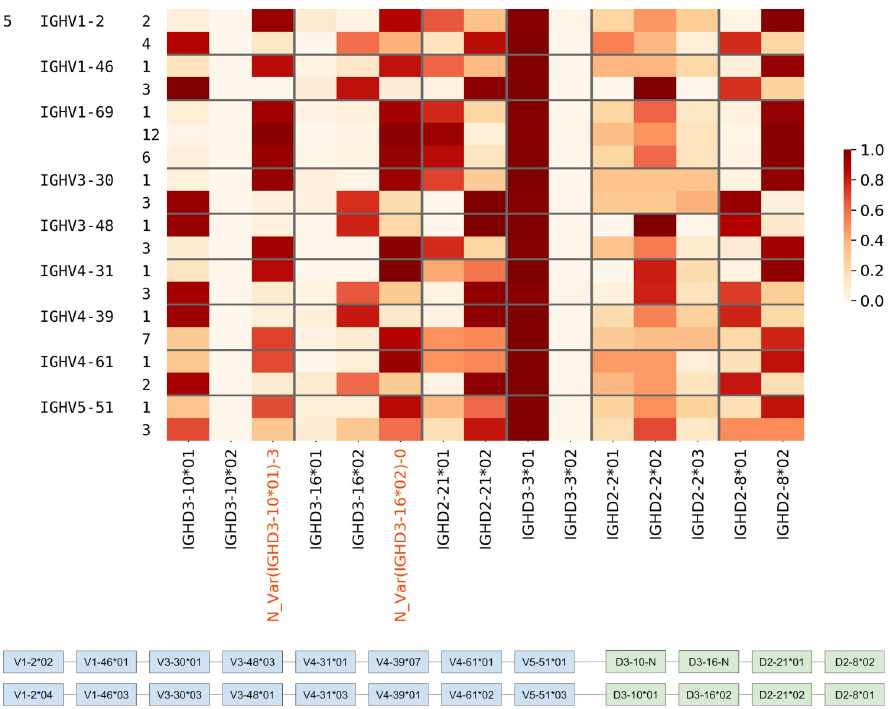
Fig 10. Haplotypes of IGHV genes for individual 5 from the Intestinal datasets (Figure J) (see legend for Fig 9).